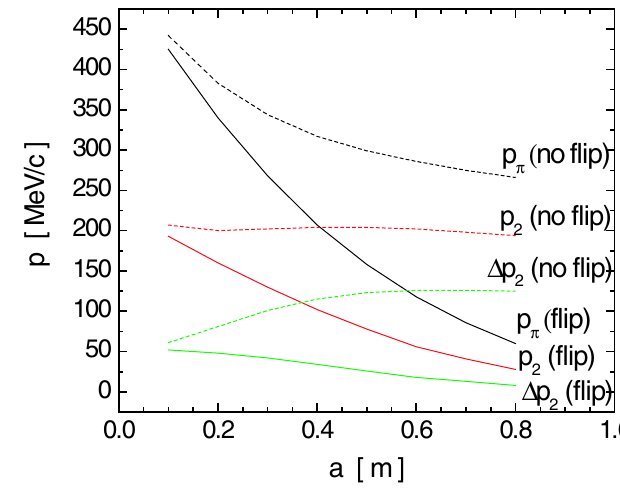
FIG. 6. (Color) Location of the (cid:8) resonance, and the midpoint and width of the second band as a function of the coil radius. The other parameter values were d (cid:2) 100 cm , L (cid:2) 50 cm , t (cid:2) 10 cm , and J (cid:2) 100 A = mm 2